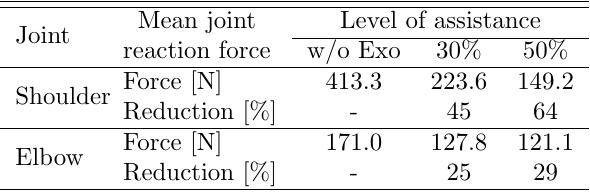
Table 4: Magnitude of the mean joint reaction forces during biceps curl Mean joint Joint